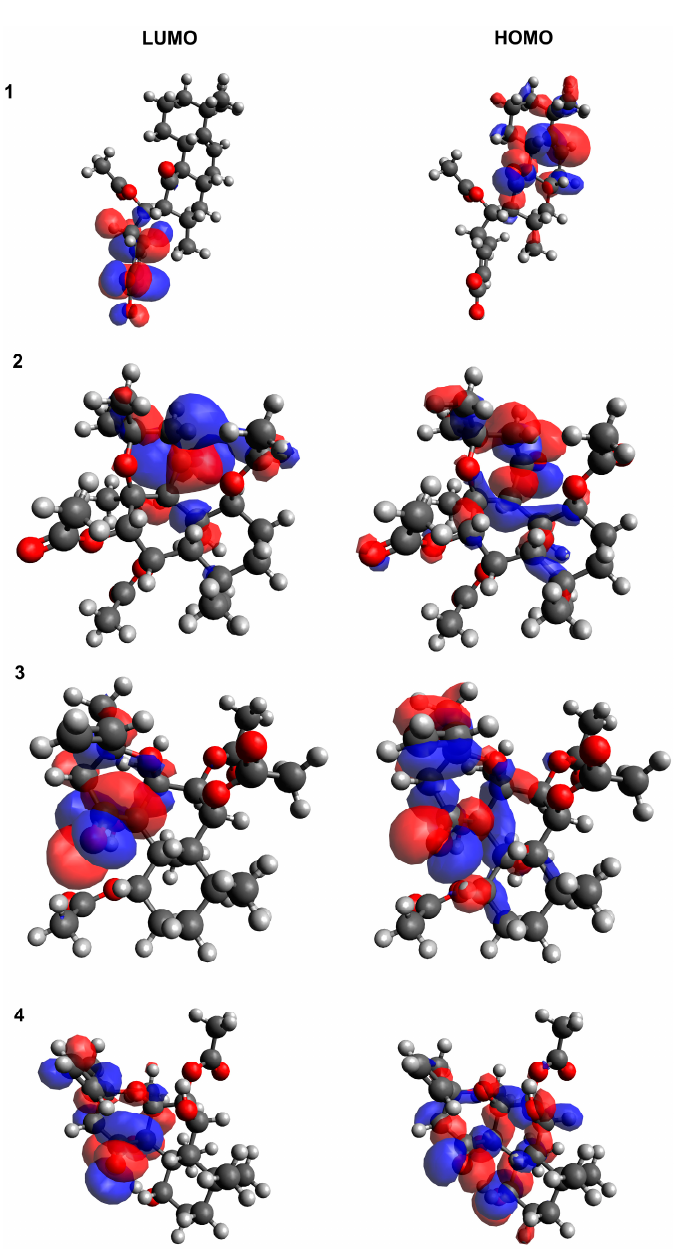
Figure 9. The HOMO/LUMO electron densities in molecules of A–D studied compounds. ( 1 ): HAL; ( 2 ) 1,6-di- O -acetylforskolin; ( 3 ) 1,6-di- O -acetyl-9-deoxyforskolin; ( 4 ) ( 2 ): 1,6-di-O-acetylforskolin; ( 3 ): 1,6-di-O-acetyl-9-deoxyforskolin; ( 4 ): PLEC.